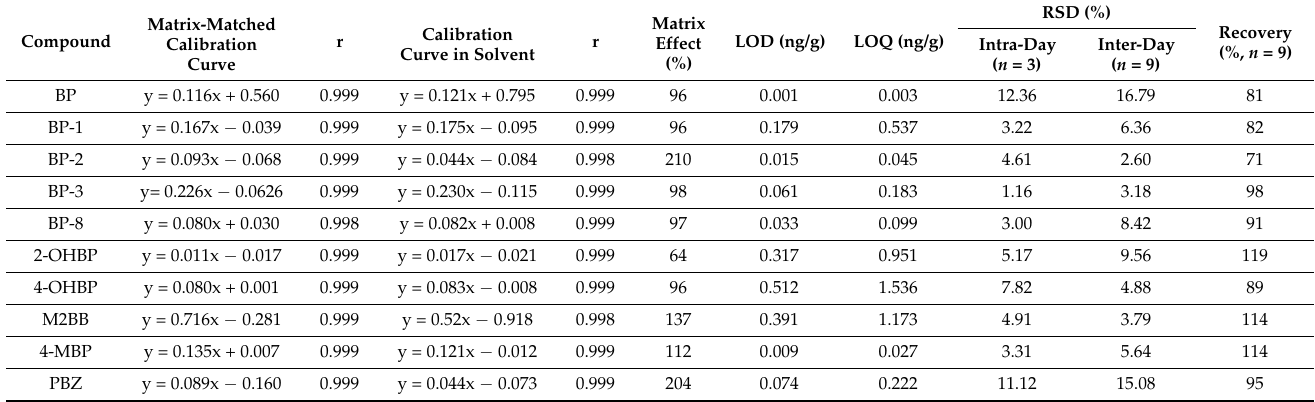
Table 2. Matrix-matched and solvent-matched calibration curves, matrix effect, LOD, LOQ, precision, and accuracy in rice